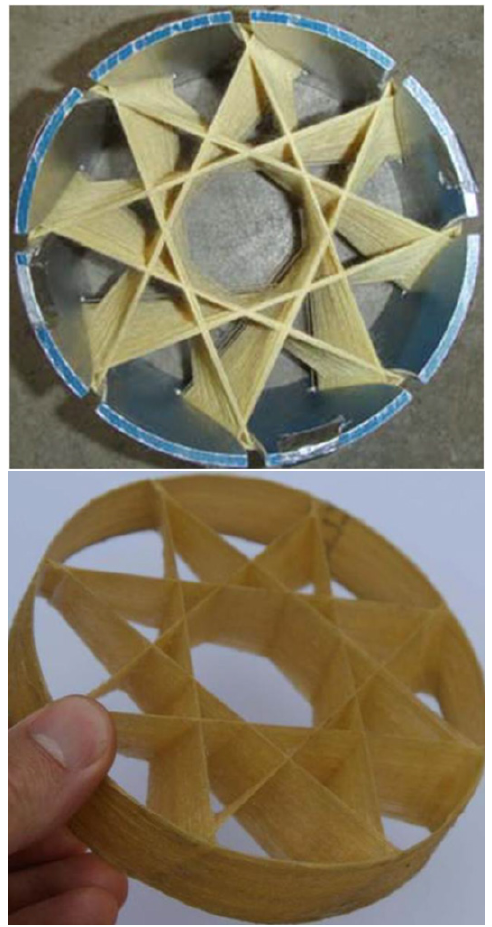
Figure 1. Prototypes of Kevlar fiber/ epoxy matrix composite mate- rial